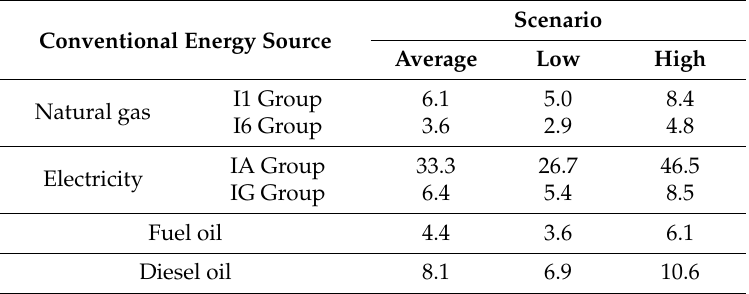
Table 24. Thermal energy unit costs, conventional energy sources (c €